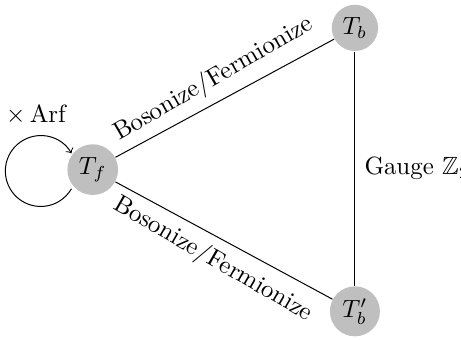
Figure 1 . Gauging the ( − 1) F symmetry of a fermionic theory T f produces a bosonic theory T b with Z 2 symmetry. A different bosonic theory T 0 is produced if one first stacks the fixed T f with b the Arf theory. These two theories are related by Z 2